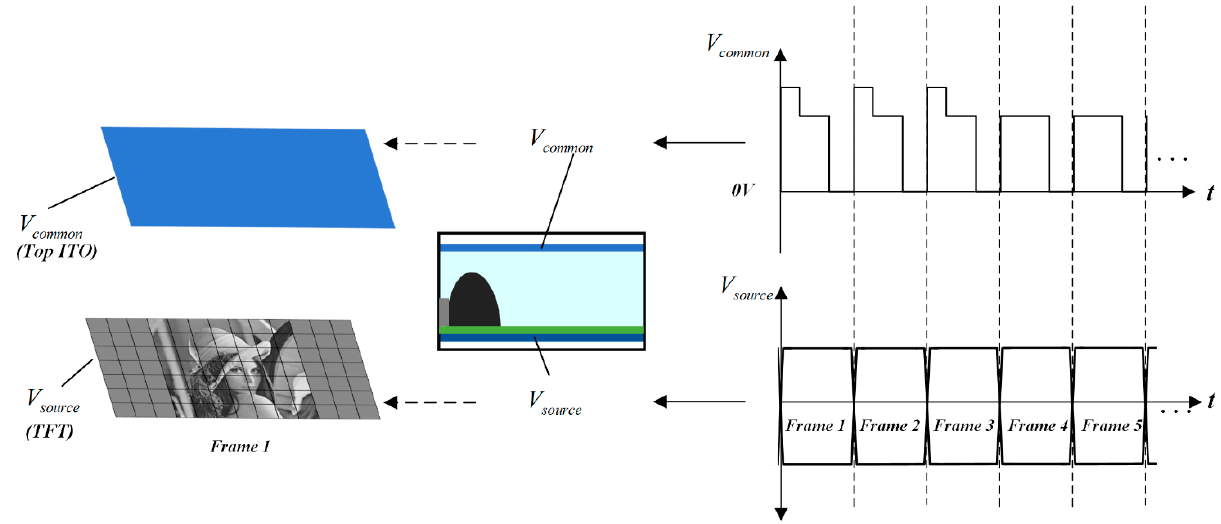
Figure 3. Schematic diagram of multi-DC driving waveform applied on TFT-EWD.